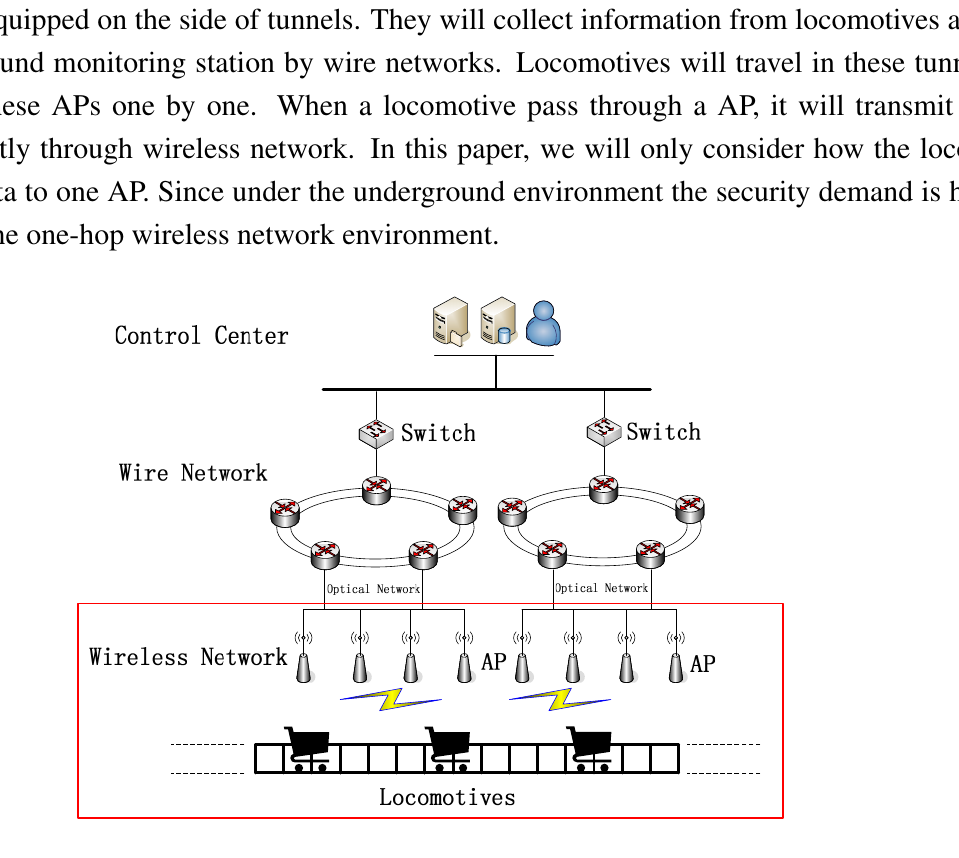
Figure 1. A typical mine locomotive wireless network